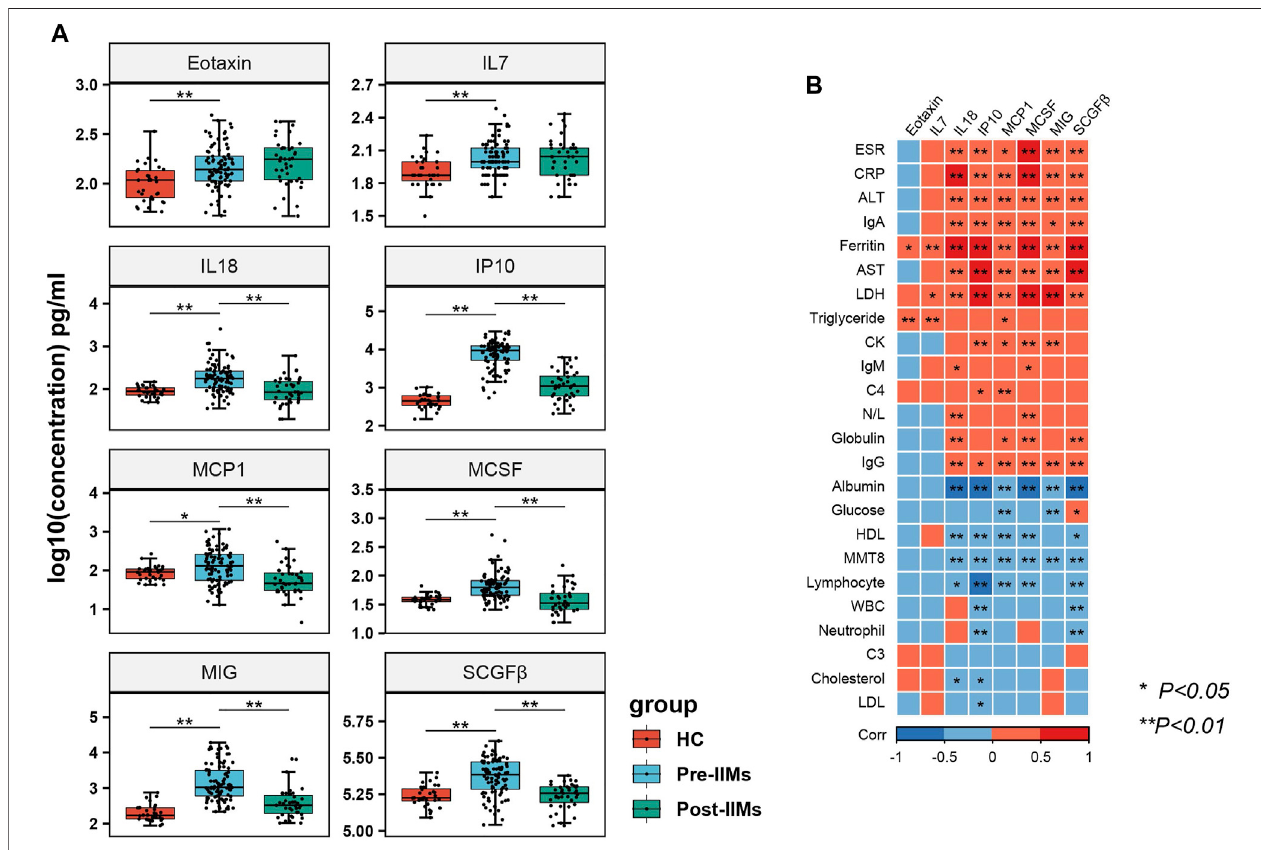
FIGURE 1 | The expression of cytokine pro fi les and correlation analysis in IIMs. (A) Comparison of cytokines expressions among IIMs patients (before and after treatment)andhealthycontrols(HC).TheHuman48-PlexLuminexassayforcytokineswasperformedintheserumofIIMspatients,including93untreatedand18follow- up(39samples)patients,and32healthycontrols.Mann-WhitneyUtestwasusedtocomparethemarkedgroups.* p < 0.05,** p < 0.01.Pre-IIMs:IIMsbeforetreatment; Post-IIMs: IIMs after treatment (glucocorticoids and other immunosuppressive therapies). (B) Correlation analysis among cytokines and clinical indices in